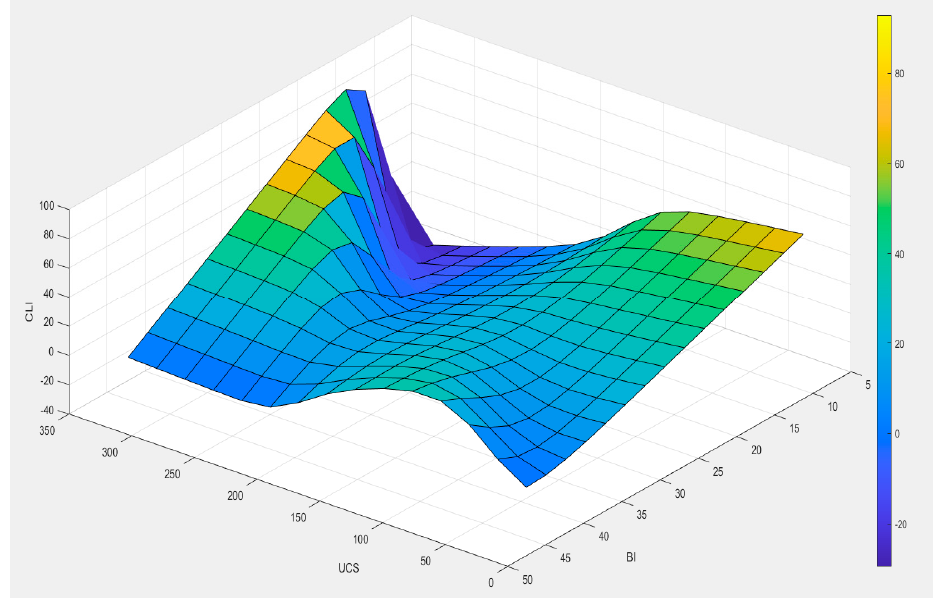
Figure 20. Fuzzy logic surface view for inputs (BI, UCS) and CLI.